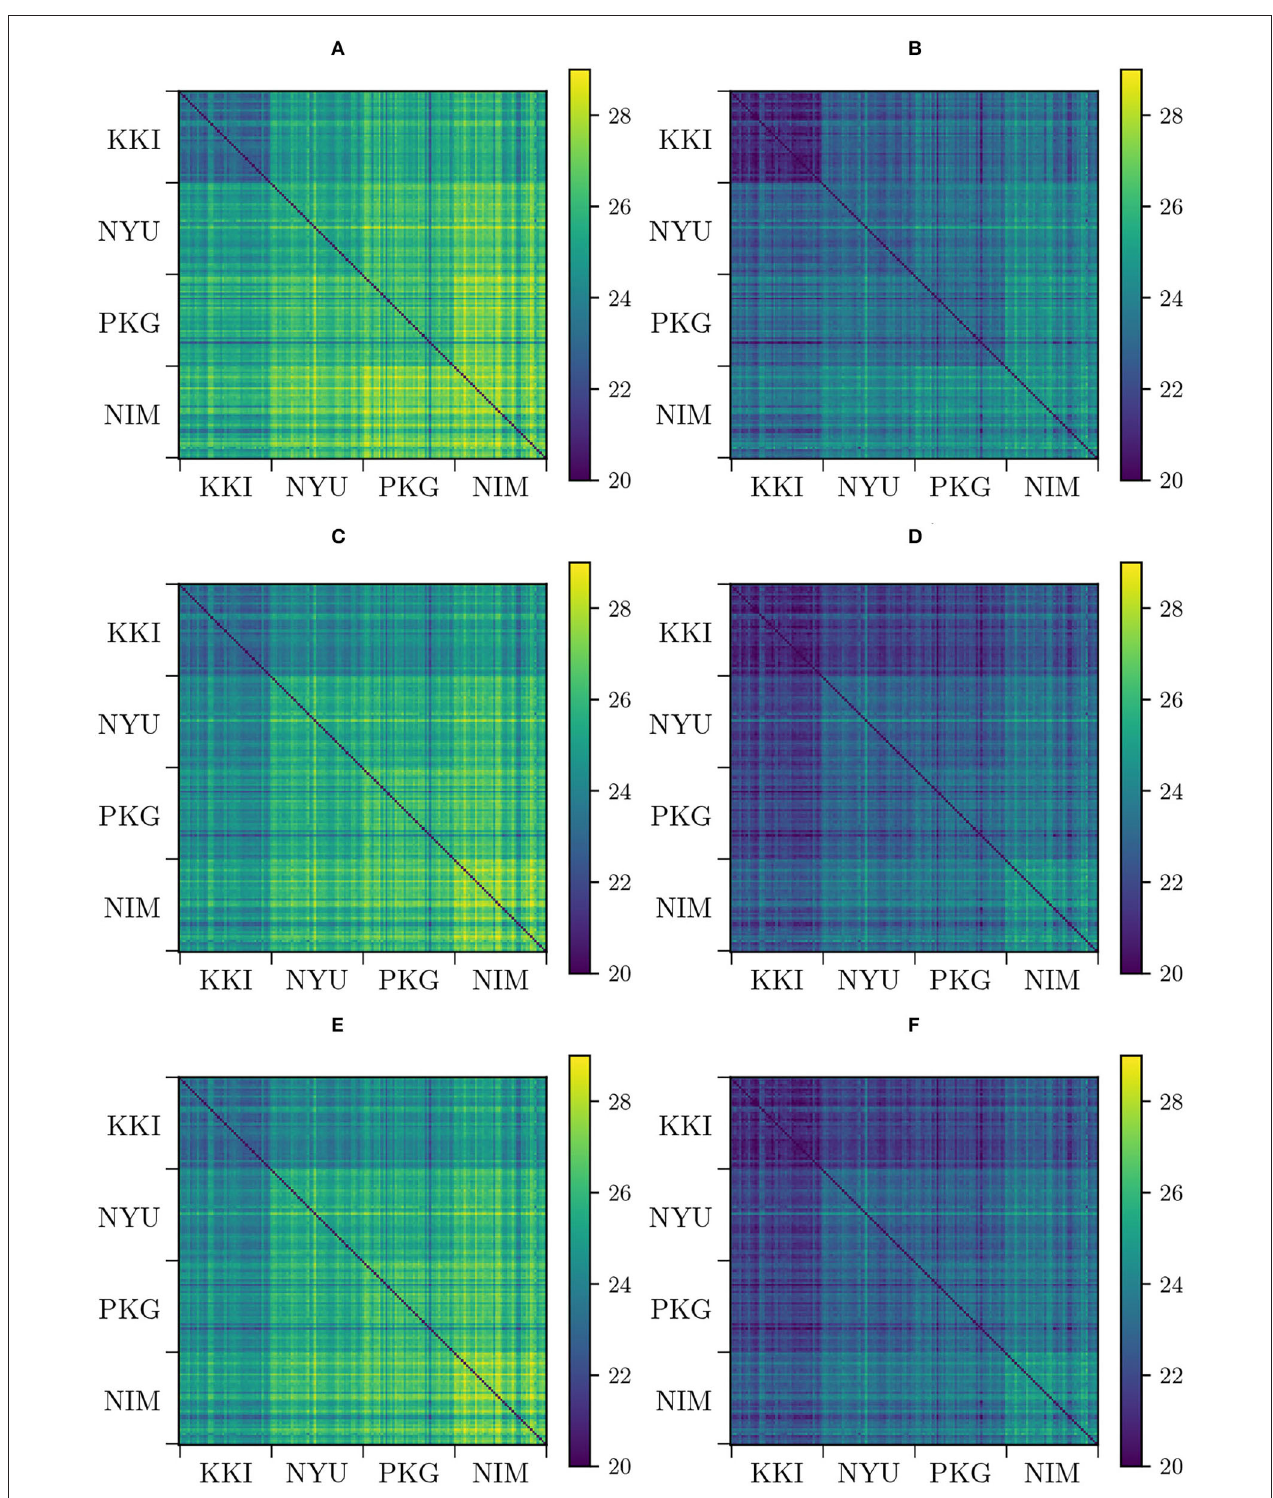
FIGURE 1 | Pair-wise distances between functional connectivity matrices from different sites (KKI: Kennedy Krieger Institute, Johns Hopkins University; NYU: New York University Child Study Center; PKG: Peking University; NIM: NeuroIMAGE sample). (A) Pair-wise affine-invariant Riemannian metric (AIRM) distances for non-transformed matrices. (B) Pair-wise Log-Euclidean Riemannian metric (LERM) distances for non-transformed matrices. (C) Pair-wise AIRM distances after matrix whitening. (D) Pair-wise LERM distances after Rigid Log-Euclidean Translation (RLET) to the global mean 6 . (E) Pair-wise AIRM distances after parallel transport. (F) Pair-wise LERM distances after RLET to the identity